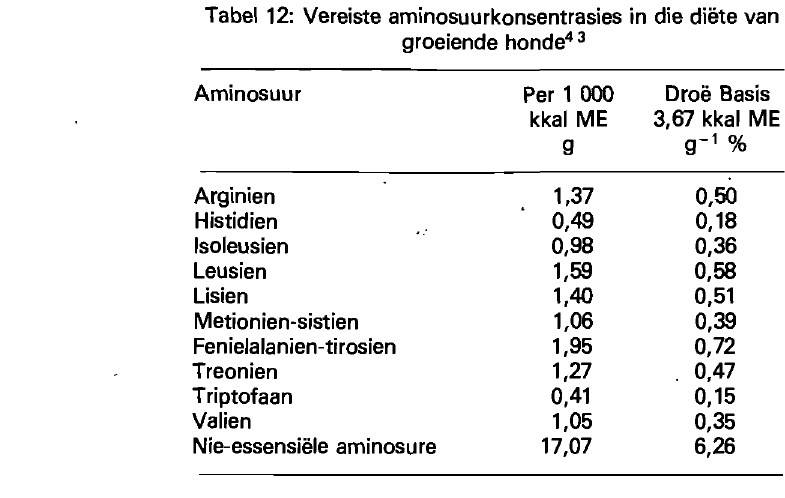
Tabel 12: Vereiste aminosuurkonsentrasies in die diete van groeiende honde